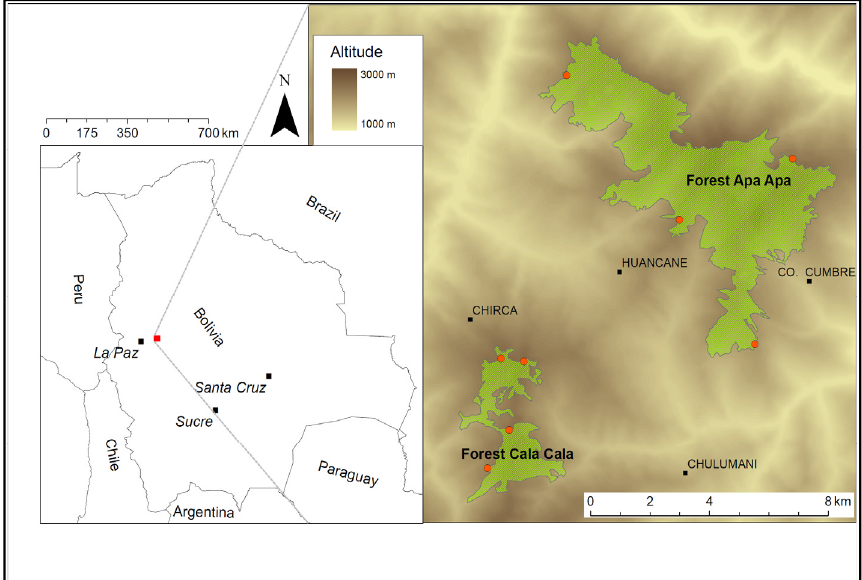
Figure 1 . Map of the study area in the Bolivian Andes. Forest remnants are shown in green, the eight study sites at the forest borders are marked by red